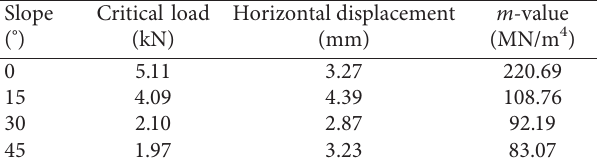
Table 9: m -value based on effective calculative width. Slope